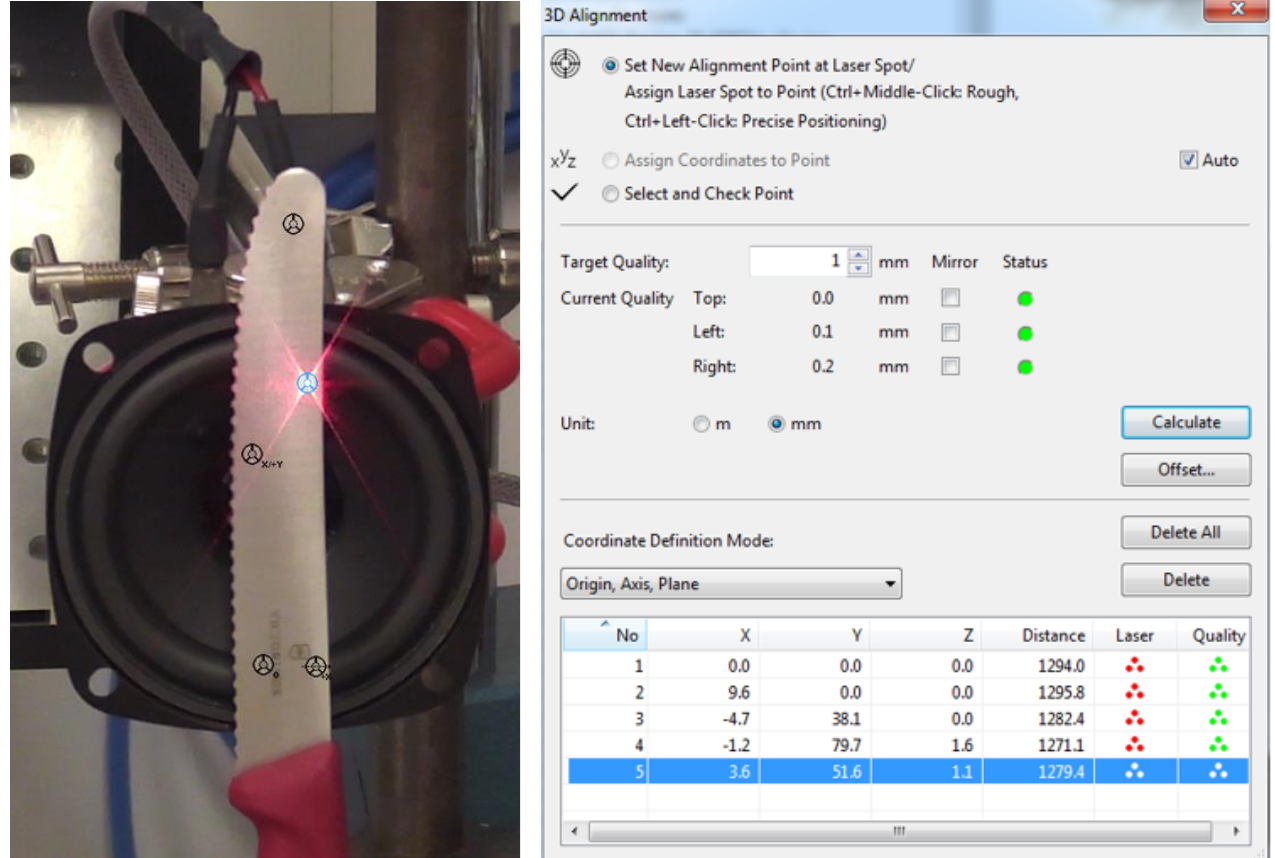
Figure 6. Test object coordinate system and 3 sensors ’ (heads ’ ) 3D alignment.